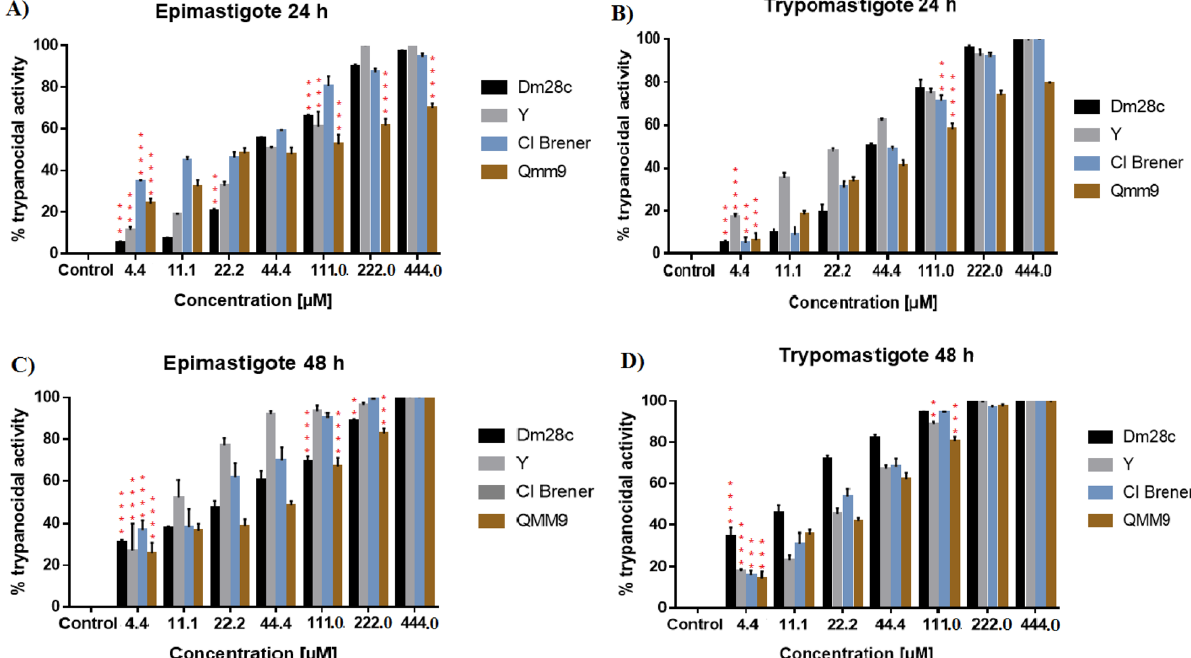
Figure 1. Evaluation of resazurin reduction inhibition by different strains and forms of Trypanosoma cruzi treated with DETC. Parasitic inhibition of resazurin reduction (%) of DETC against different forms (epimastigotes and trypomastigotes) and strains (Y, Dm28c, CL Brener, and QMM9) of T. cruzi , after 24 and 48 h of culture and analysed by resazurin assay. (A) Epimastigotes for 24 h of treatment; (B) Trypomastigotes for 24 h of treatment; (C) Epimastigotes for 48 h of treatment; (D) Trypomastigotes for 48 h of treatment. Results presented as mean ± standard deviation of the percentage of parasitic inhibition in a triplicate system and for the statistical analysis of the Anova Test, together with the Tukey Post-test (P < 0.01 (**); P < 0.001 (***), P < 0.0001(****). In order to verify differences, the profile of each strain was compared against others treated with the same concentration of DETC. Software GraphPad Prism v. 7.0 (2016) (https:// www. graph pad. com/ )